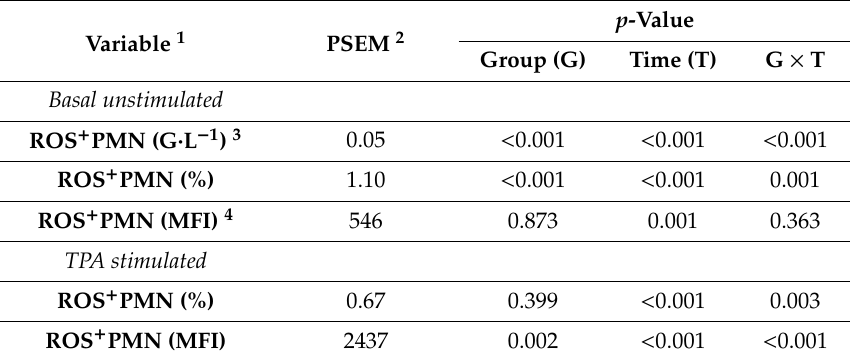
Table 6. Results of the statistical analyses.